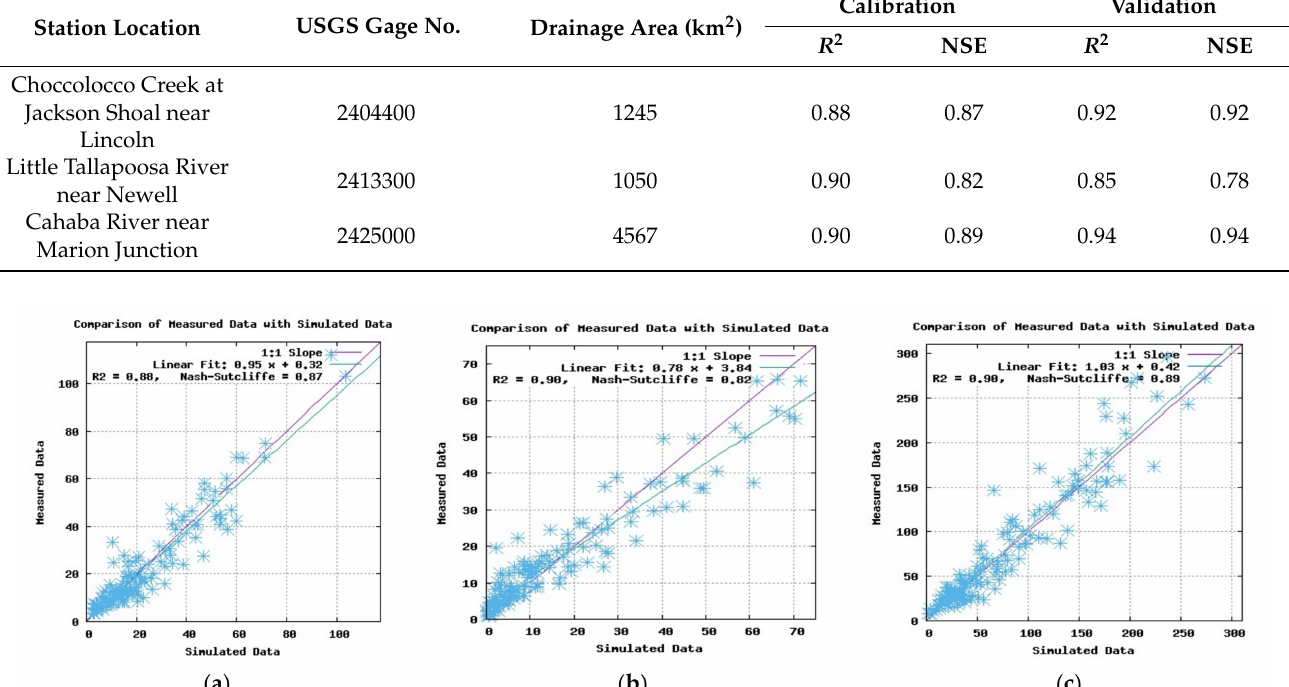
Table 5. Model performance statistics for streamflow calibration and validation.